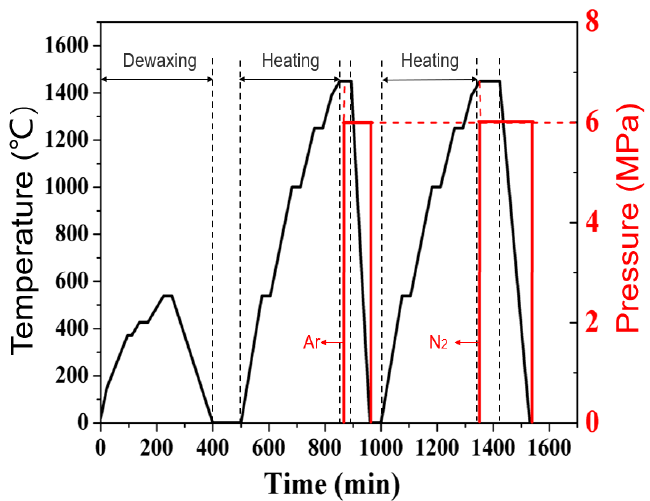
Figure 1. Dewaxing and two-step sinter-hip process for FGCs.